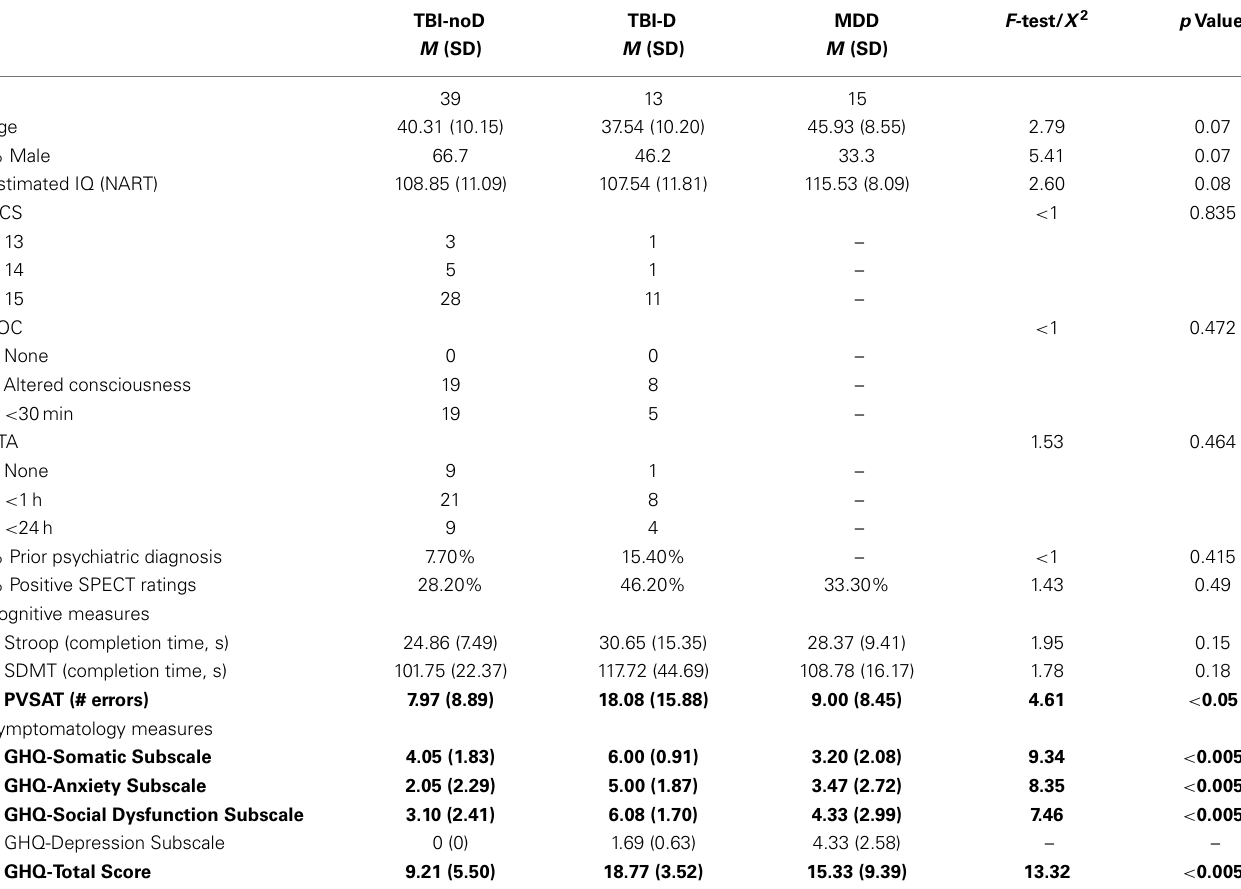
Table 1 | Demographical and clinical information forTBI patients with depressive symptoms,TBI patients without depressive symptoms, and patients with MDD